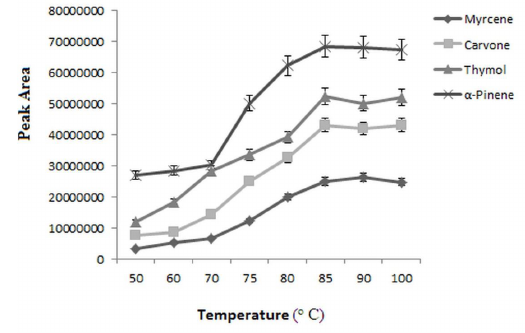
Fig. 1. Effect of extraction time on extraction efficiency Fig. 3 . Effect of sample weight on extraction efficiency.